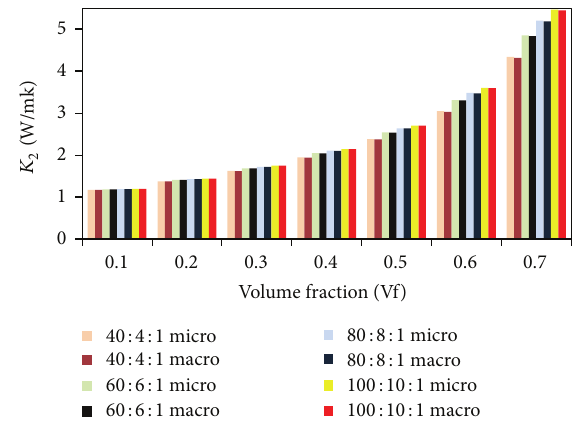
Figure 11: Variation in 𝐾 2 of hybrid composite with respect to Vf for different 𝐾 𝑓1 : 𝐾 𝑓2 : 𝐾 𝑚 .